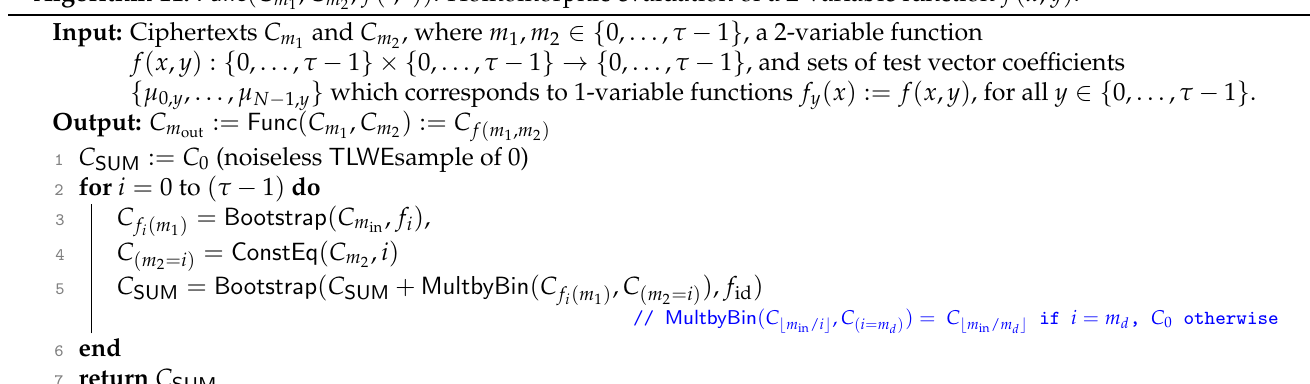
Algorithm 11: Func ( C m